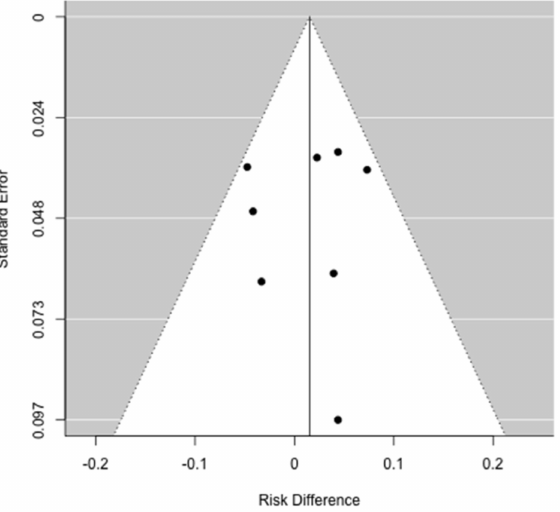
Figure 5. Funnel plot for the difference in the prevalence of major complications. No publication bias was